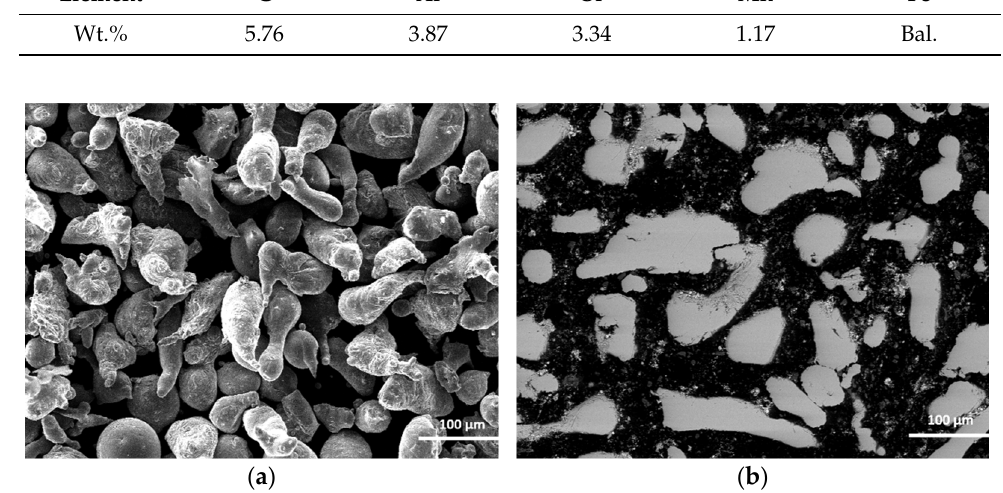
Figure 1. Iron-based powder: ( a ) global morphology, ( b ) cross-sectional microstructure.